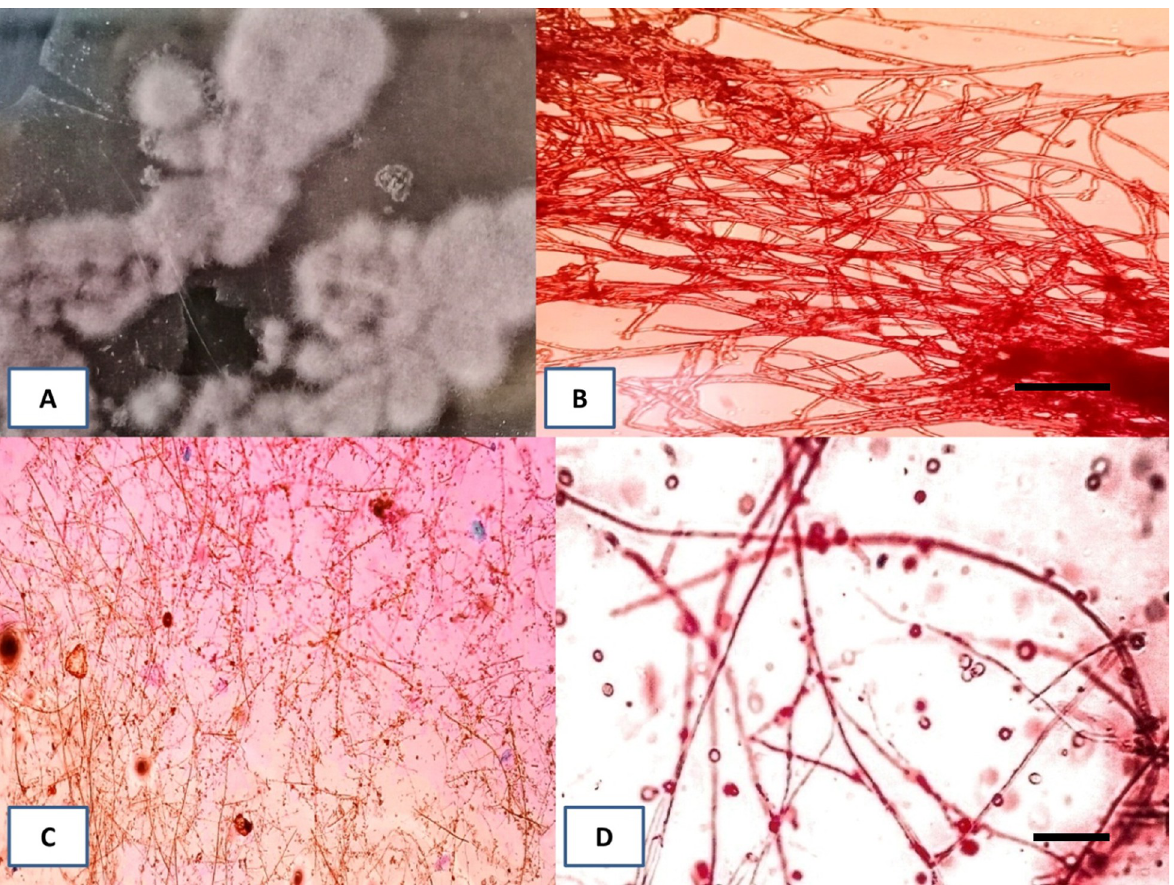
Fig 1. Representative pictures of P . lilacinum . (A) Fungus culture on PDA media. (B) Mycelium of fungi. Scale bar = 25 μ m (C and D) Mycelium and conidia of fungi. Scale bars = 50 μ m.